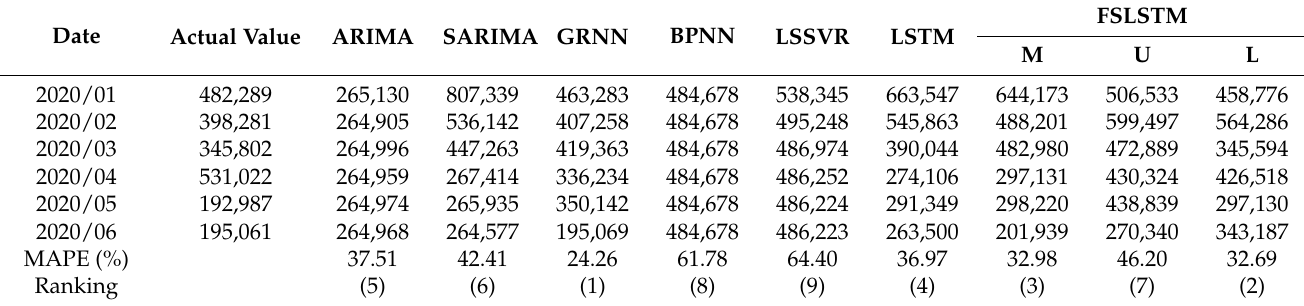
Table 5. Comparison of the forecasting results for the Shimen wind power